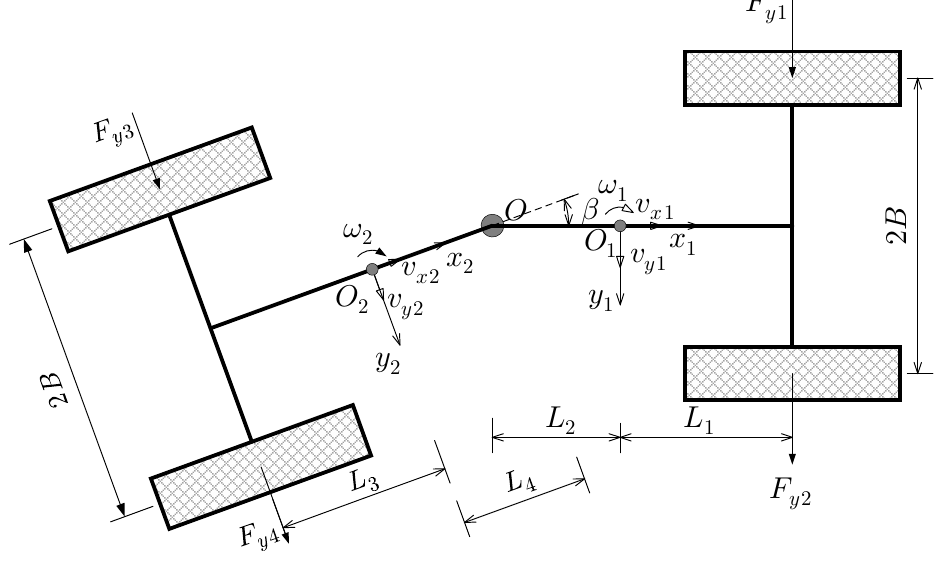
Figure 5. Simplified model of vehicle